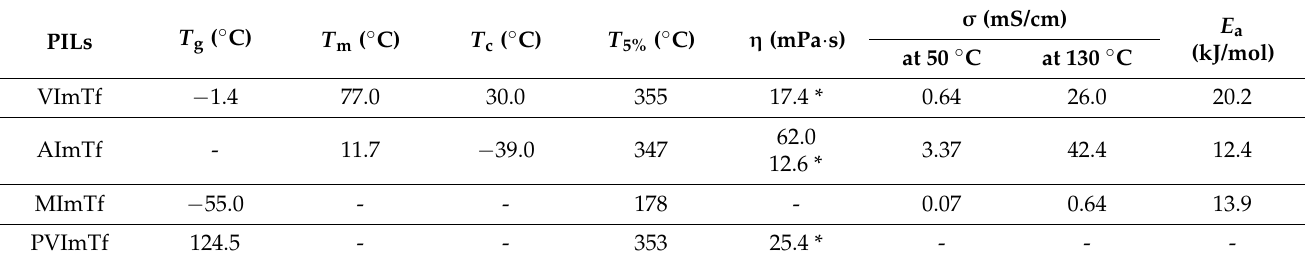
Table 1. Physical–chemical characteristics of the synthesized PILs. Table 1. Physical – chemical characteristics of the synthesized PILs. PILs